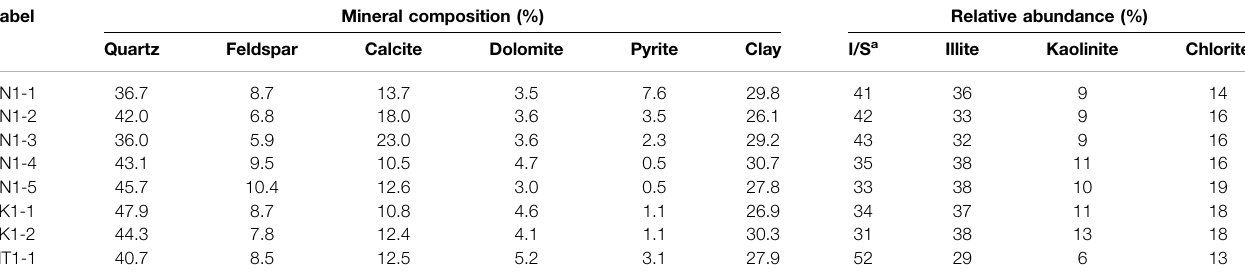
TABLE 2 | Mineral composition analysis. Label Mineral composition (%) Relative abundance (%) Quartz